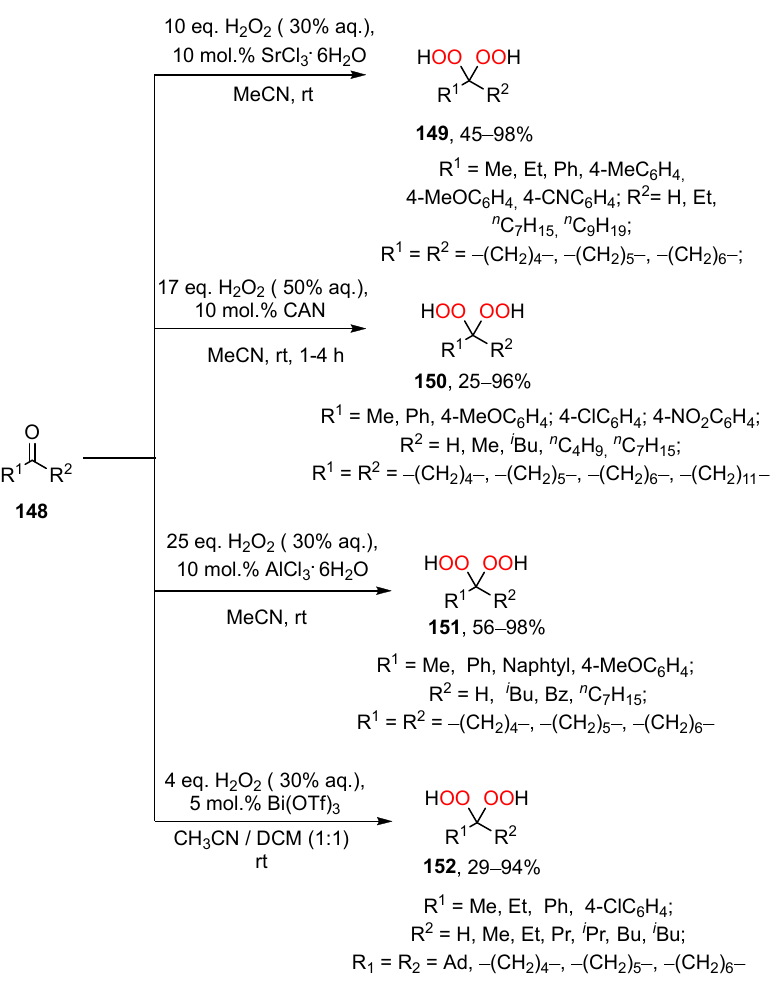
Scheme 51. Synthesis of geminal bishydroperoxides 149 – 152 . Also, bismuth (III) triflate is a good catalyst for the synthesis of 1,2,4,5-tetraoxanes 155 . In this case, the target peroxides 152 were obtained in a yield up to 94%.